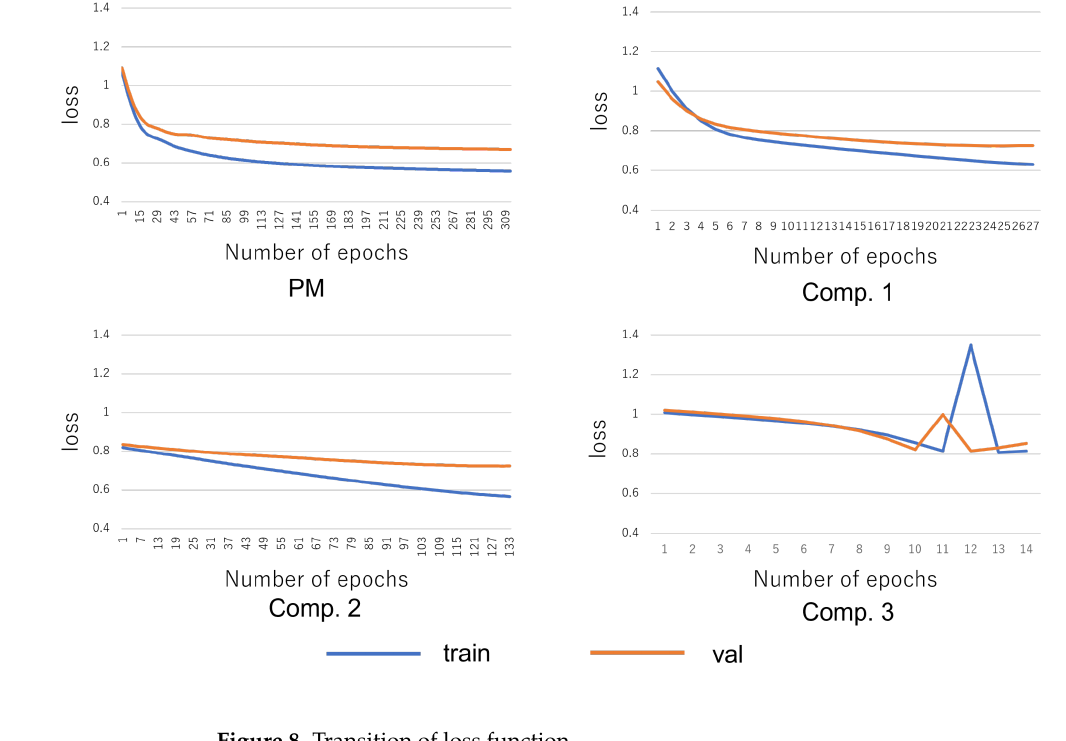
Figure 8. Transition of loss